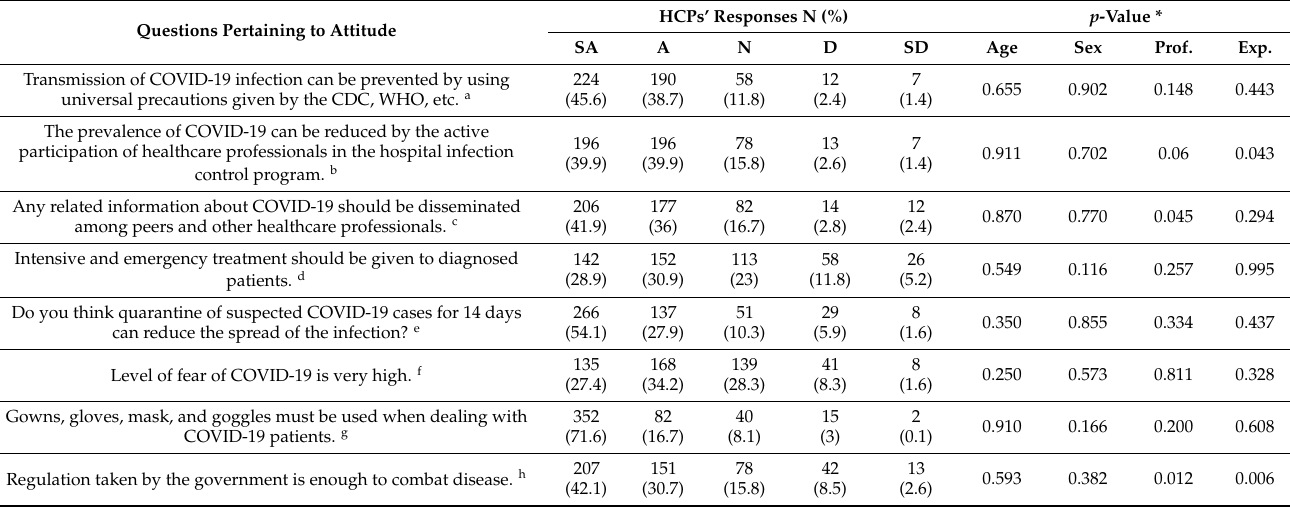
Table 3. HCPs’ attitudes towards COVID-19.